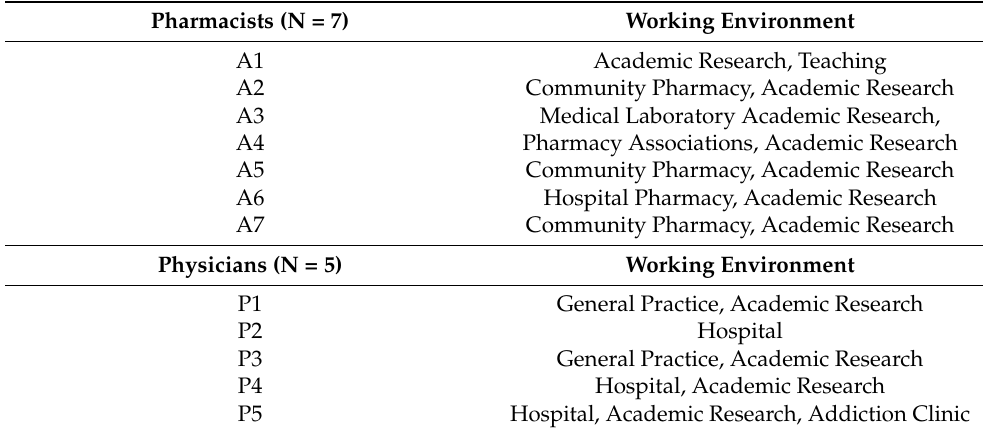
Table 1. Characteristics of the pharmacist and physician panel participants.